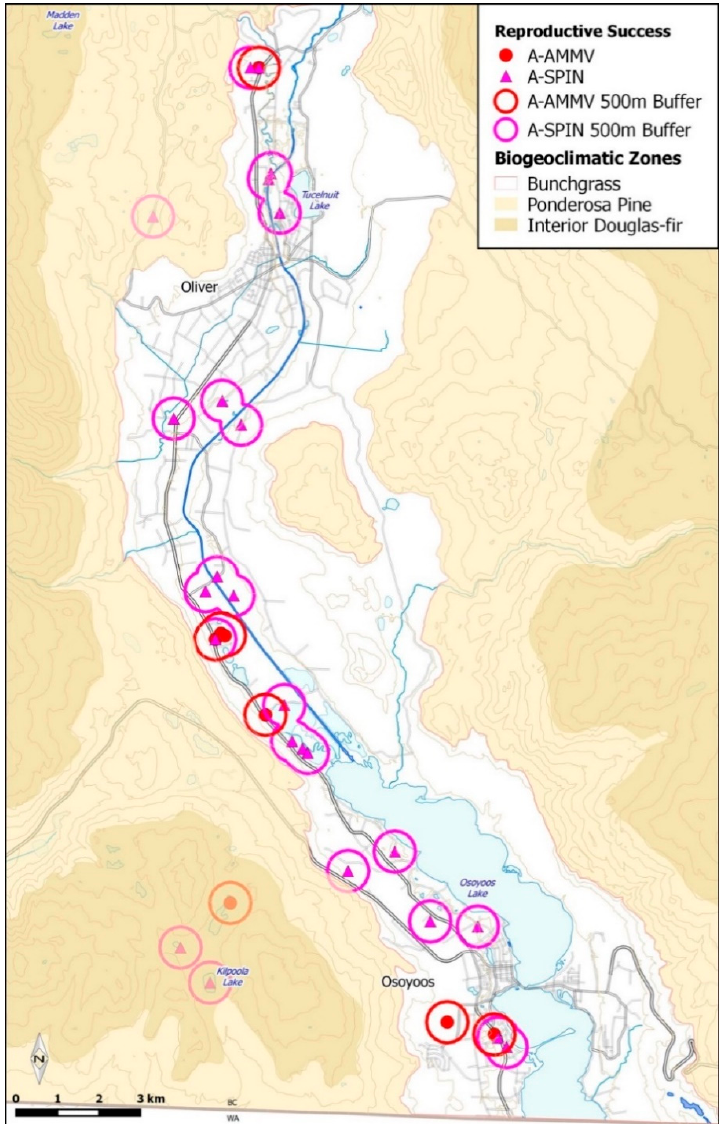
Figure 1. Biological criteria used for informing wetland enhancement and restoration activities within the south River Okanagan Valley, British Columbia study area [9]. Breeding success of known Great Basin spadefoot (pink triangle) and Blotched tiger salamander (red circle) was presumed by the presence of early life stages (e.g., eggs, tadpole/larvae, metamorph). To increase the likelihood of constructed and enhanced wetland colonization, a 500 m buffer around the known Great Basin spadefoot (pink perimeter) and Blotched tiger salamander (red perimeter) breeding sites was used to help prioritize wetland habitat activities. Amphibian (A) species codes: A-AMMV Blotched tiger salamander, A-SPIN Great Basin spadefoot. Biogeoclamatic zones include Bunchgrass, Ponderosa Pine ( Pinus ponderosa ), and Douglas-fir ( Pseudotsuga menziesii ).